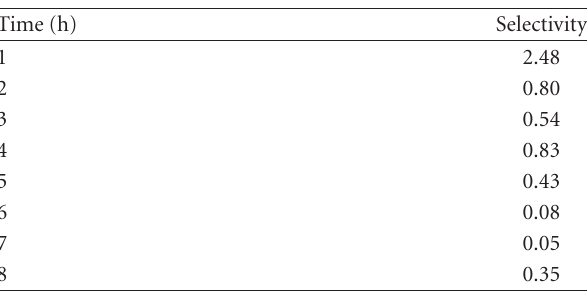
Table 3: Selectivity values as a function of